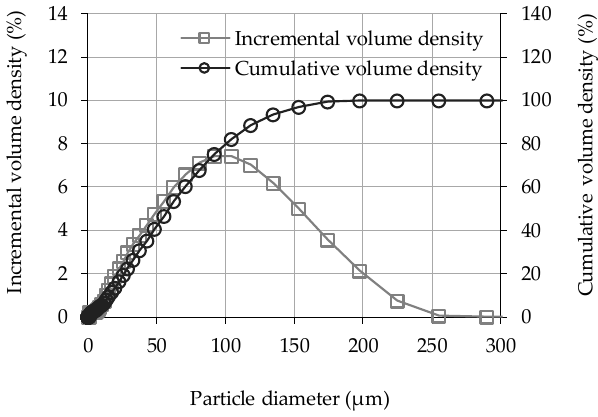
Figure 1. Incremental and cumulative particle size distributions of SAP_SP .